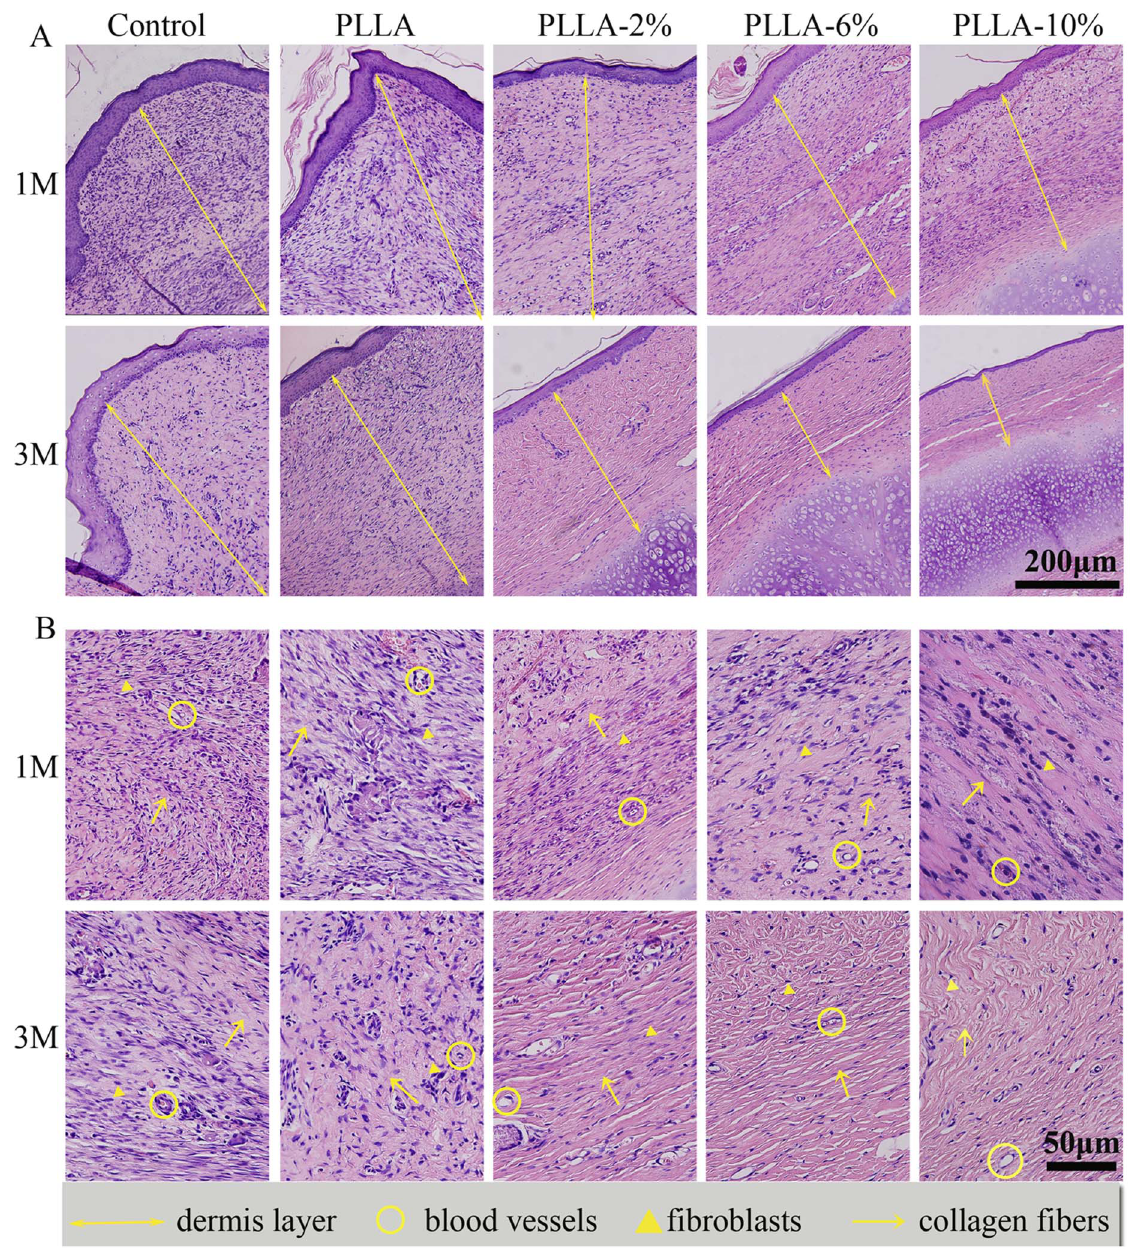
Figure 9. H&E staining of sections of scar hyperplasia at 1, and 3 months after wounding. The upper two rows show H&E staining at 100 6 . The lower two rows show H&E staining at 400 6 . The dermal layer of the control scars and the PLLA-treated scars were much thicker than